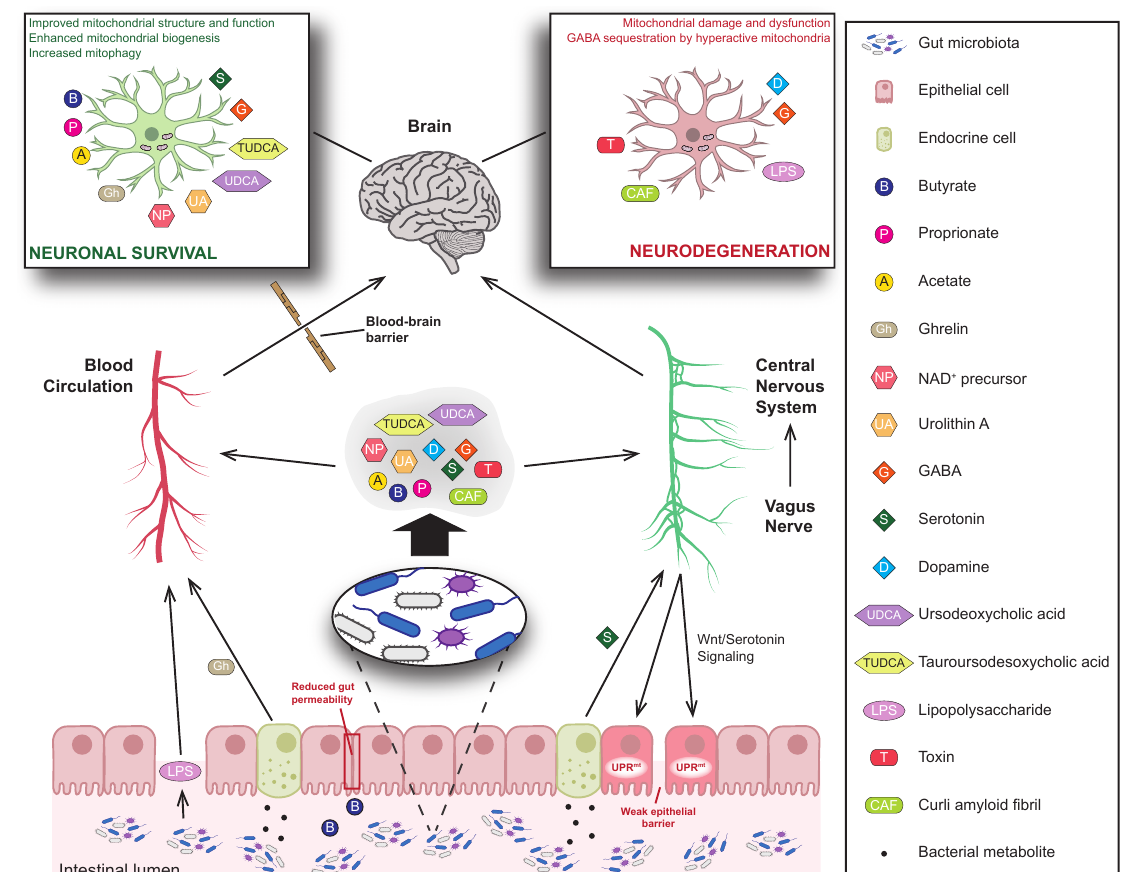
Figure 1. The implication of mitochondria in the gut–brain axis. Metabolites secreted by commensal microorganisms can affect brain mitochondria by entering the bloodstream and crossing the blood– brain barrier or by acting directly on the central nervous system through the vagus nerve. The impact of such metabolites can promote neuronal survival by improving mitochondrial quality, enhancing mitophagy and promoting organelle biogenesis, or favor neurodegeneration by inducing mitochon- drial hyperactivation, damage and dysfunction. Gut microbial metabolites can also act indirectly by affecting the permeability of the epithelium or by modulating the secretion of intestinal endocrine cells. Reversely, the nervous system can affect intestinal microbiota by activating the mitochondrial unfolded protein response (UPR mt ) of gut epithelial cells, weakening the epithelial